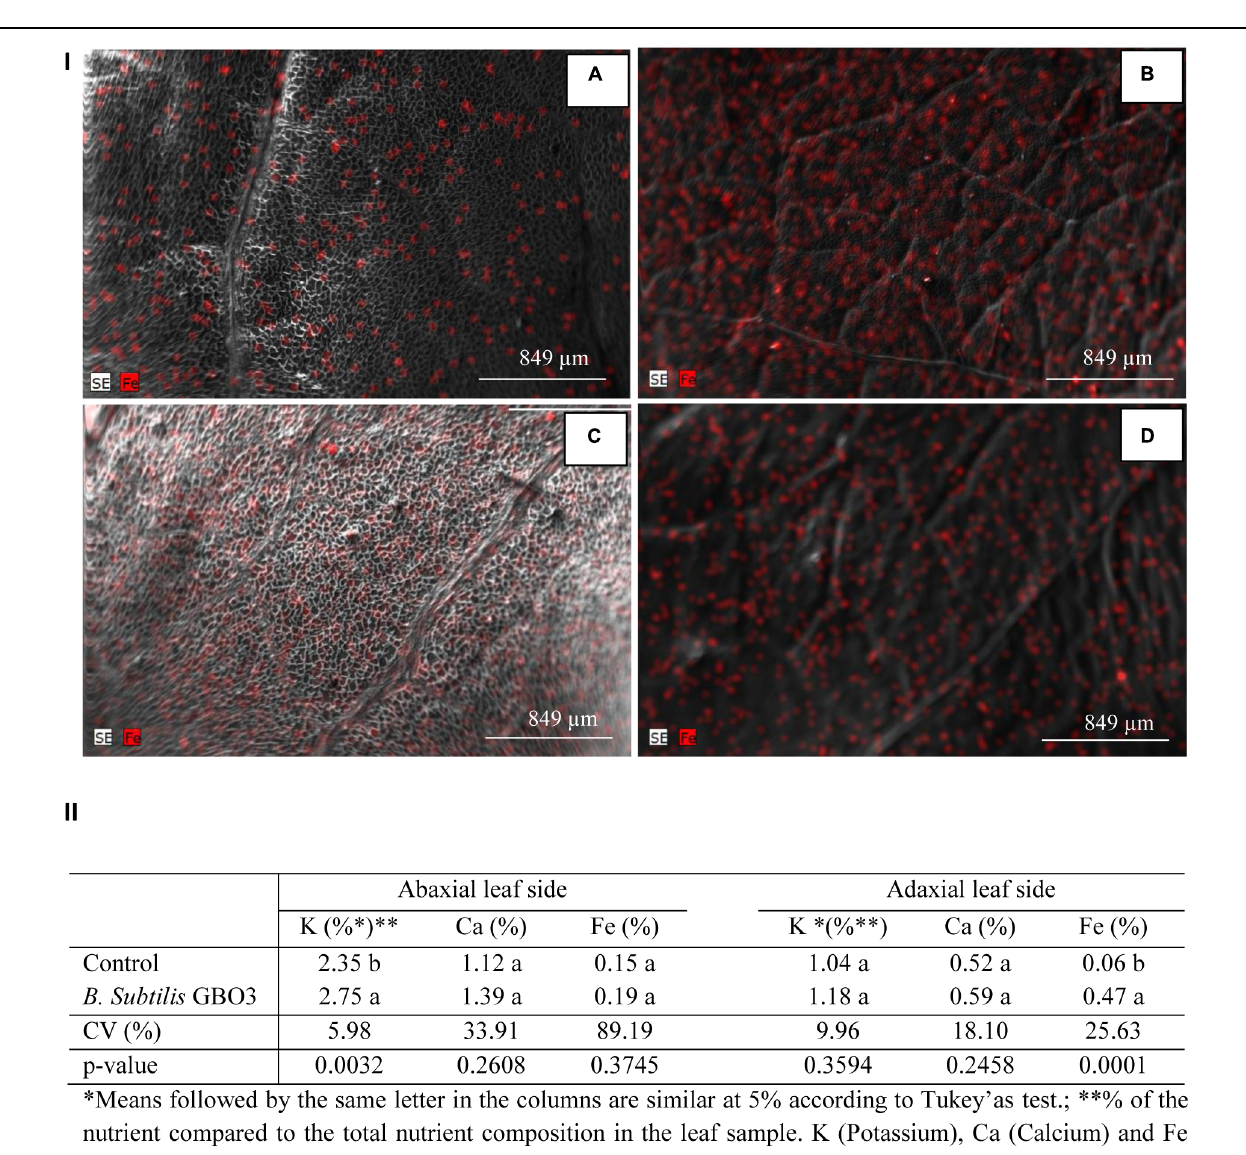
iron in the leaves; (II) Contents of iron (Fe), potassium (K), and calcium (Ca) in the adaxial and abaxial side of cassava ( M. esculenta ) determined by the Espirit 1.9 software from the X-ray generated images.